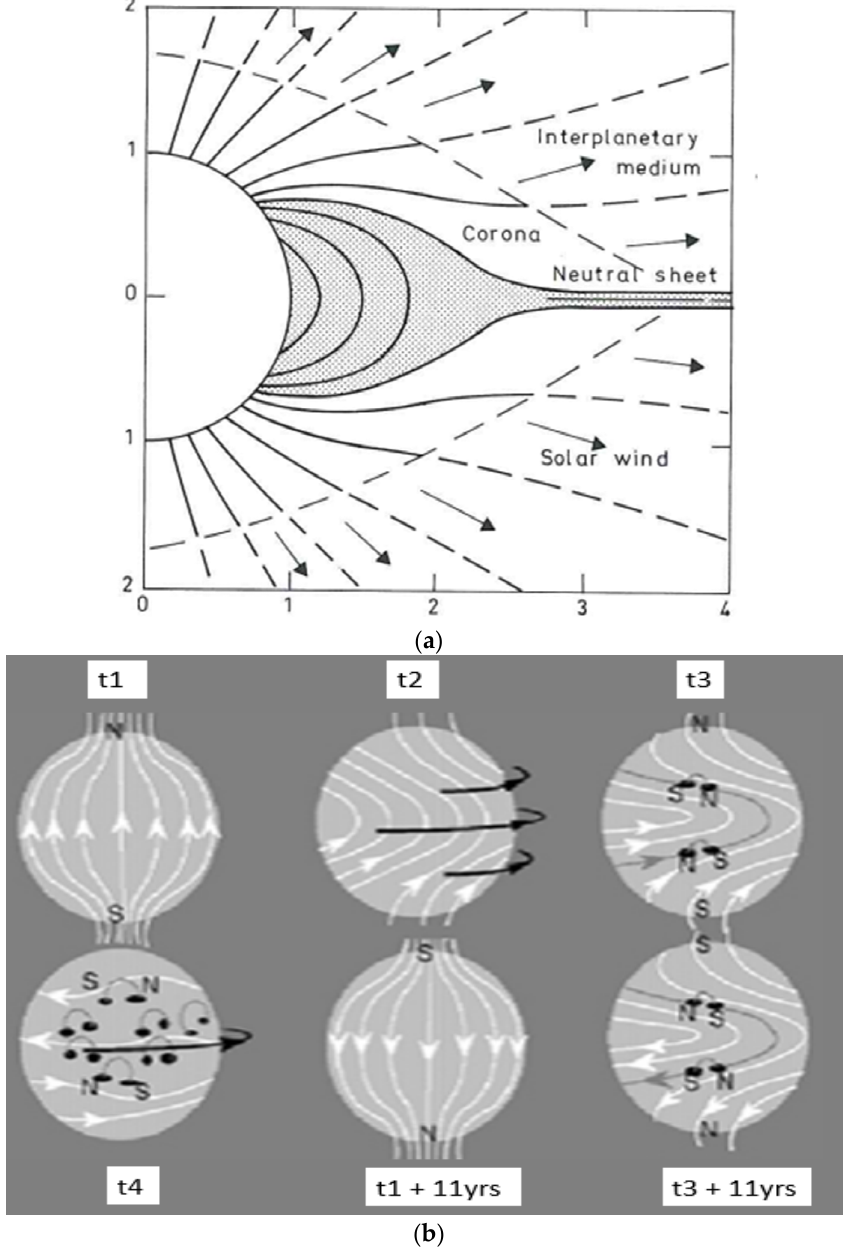
Figure 2. Solar dipole, the poloïdal and toroïdal components of the solar magnetic field ( a,b ) [14].